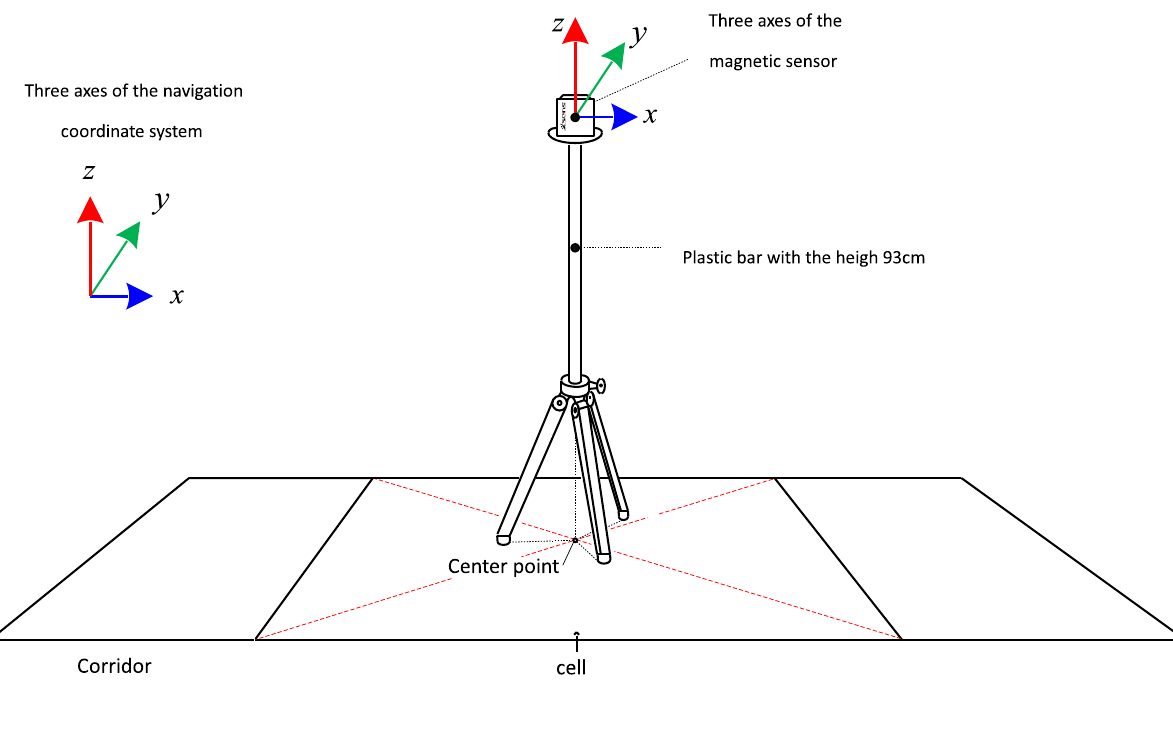
Figure 2. Magnetic signature measurement for each